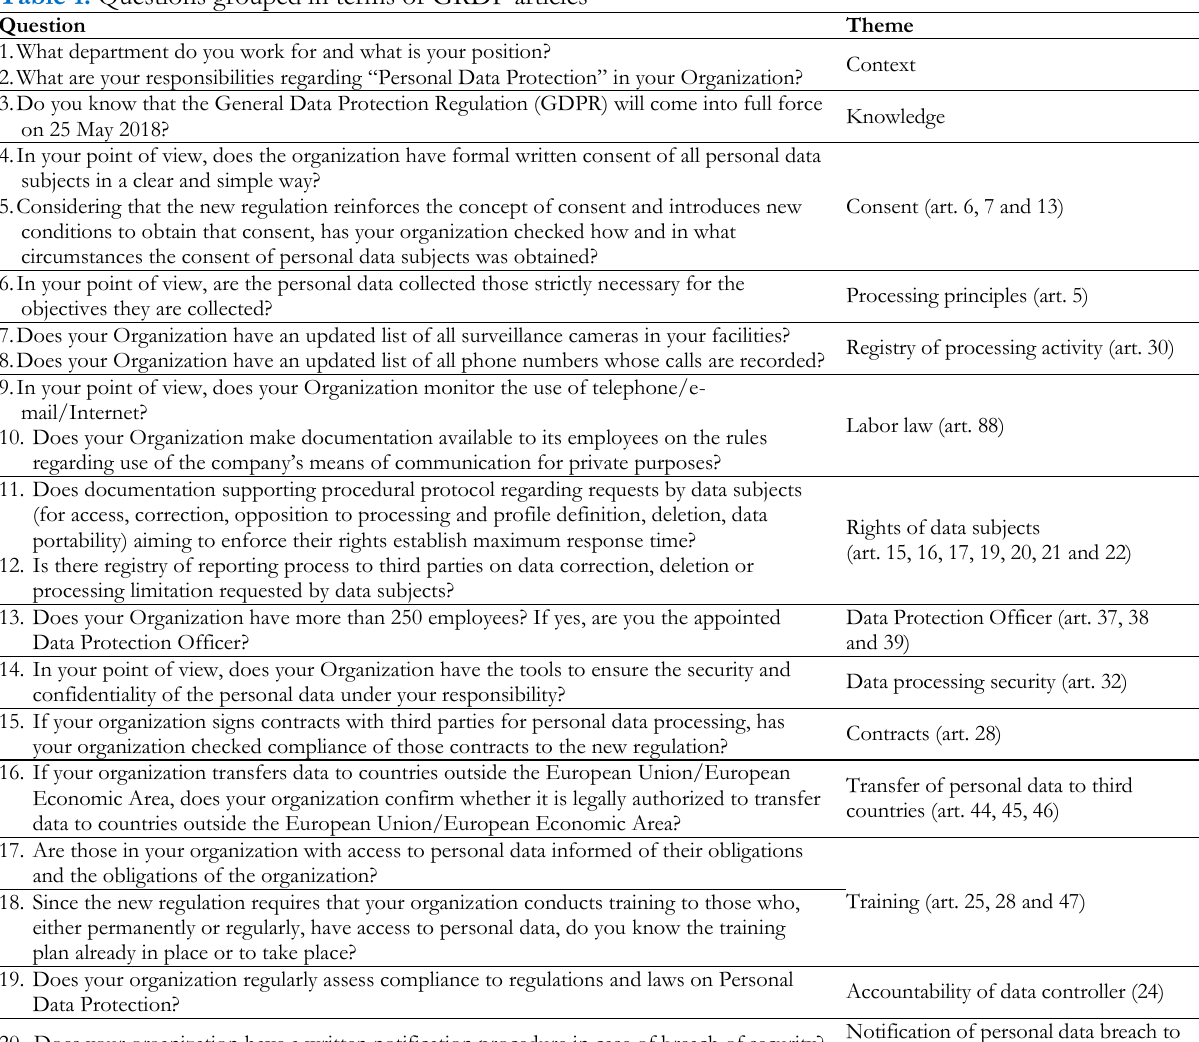
Table 1. Questions grouped in terms of GRDP